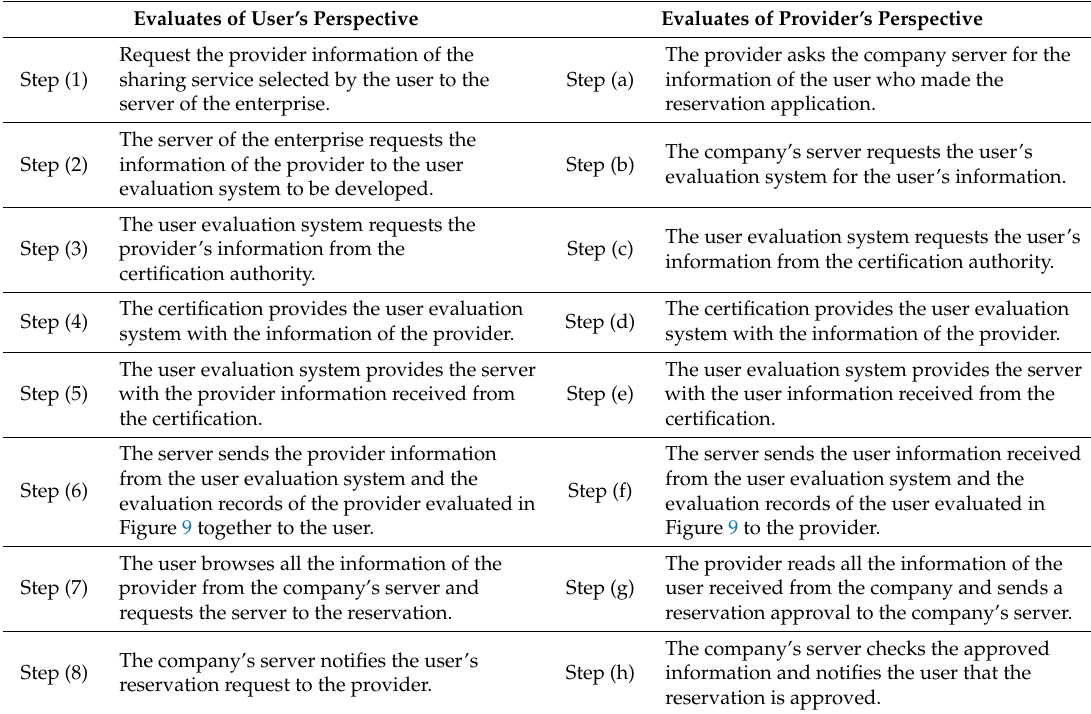
Table 2. Procedure for judging the quality of the shared object in the system.